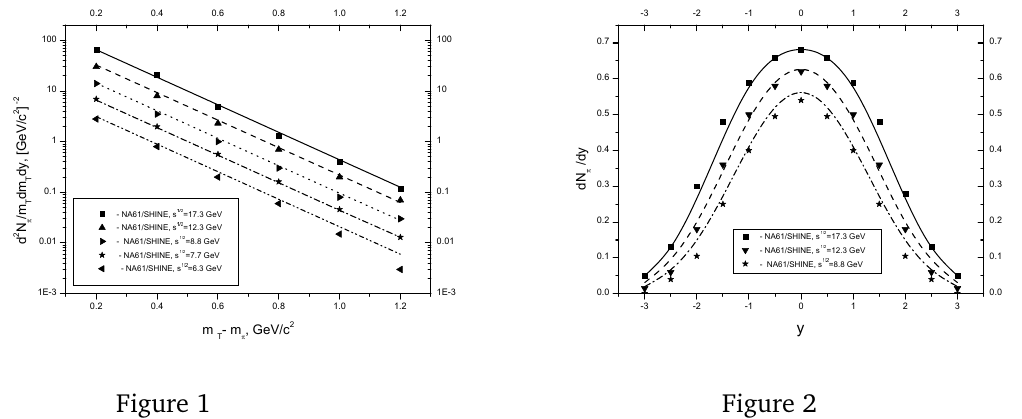
are the p and rapidity distributions of pions coming from Eq.(11) at T T normalized by the experimental value of the pion rate at ( m pion rate in pp collisions [ 6 ] (the scattered symbols) at the same projectile energies, where (cid:113) = + m 2 m p 2 , whereas m π is the pion mass. In Fig2. the rapidity distributions coming (cid:112) π T T s = 17,3 GeV (solid lines), from Eq.(11) at = 160 MeV v.s. the rapidity distributions in pp collisions [ 6 ] (dot-dashed line), and at T c